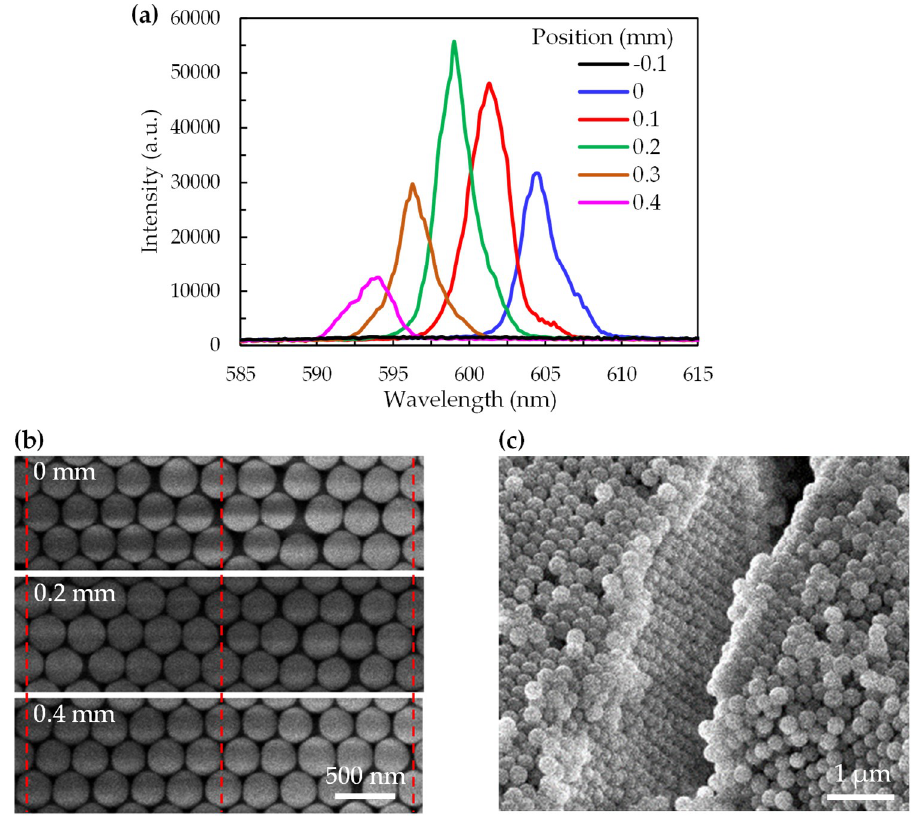
Figure 5. ( a ) The lasing spectra measured at different positions of the sample, in which position of 0 189 mm is defined as the position where the longest wavelength of lasing occurs; ( b ) The SEM images of 190 the CC layer at position of 0, 0.2, and 0.4 mm; ( c ) Cross-sectional SEM image of the CC. 191